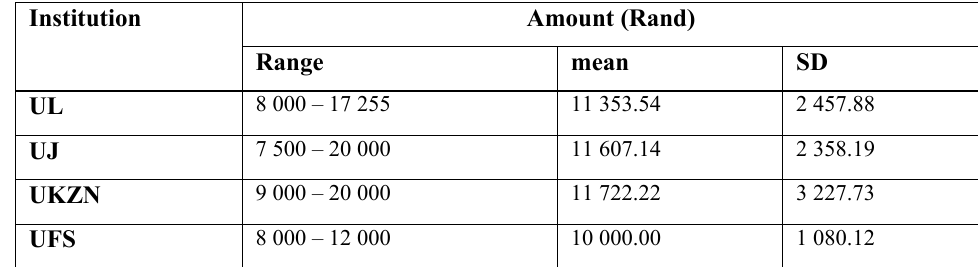
Table 11: The range, mean and standard deviation of monthly salaries that the respondents consider to be appropriate for a newly qualified optometrist employed in the private